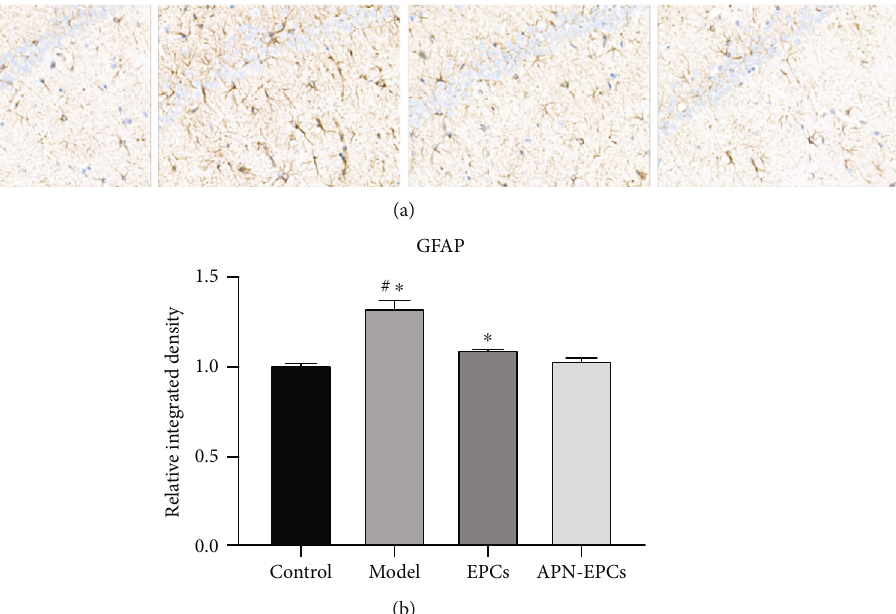
Figure 5: In fl uence of APN-EPC treatment on hippocampal astrocytes. (a). Immunohistochemistry result of GFAP in the hippocampus (x400). (b). Quantitative result of GFAP. ∗ p < 0 : 05 the model group or the EPC group compared with the APN-EPC group, # p < 0 : 05 the model group compare with the control